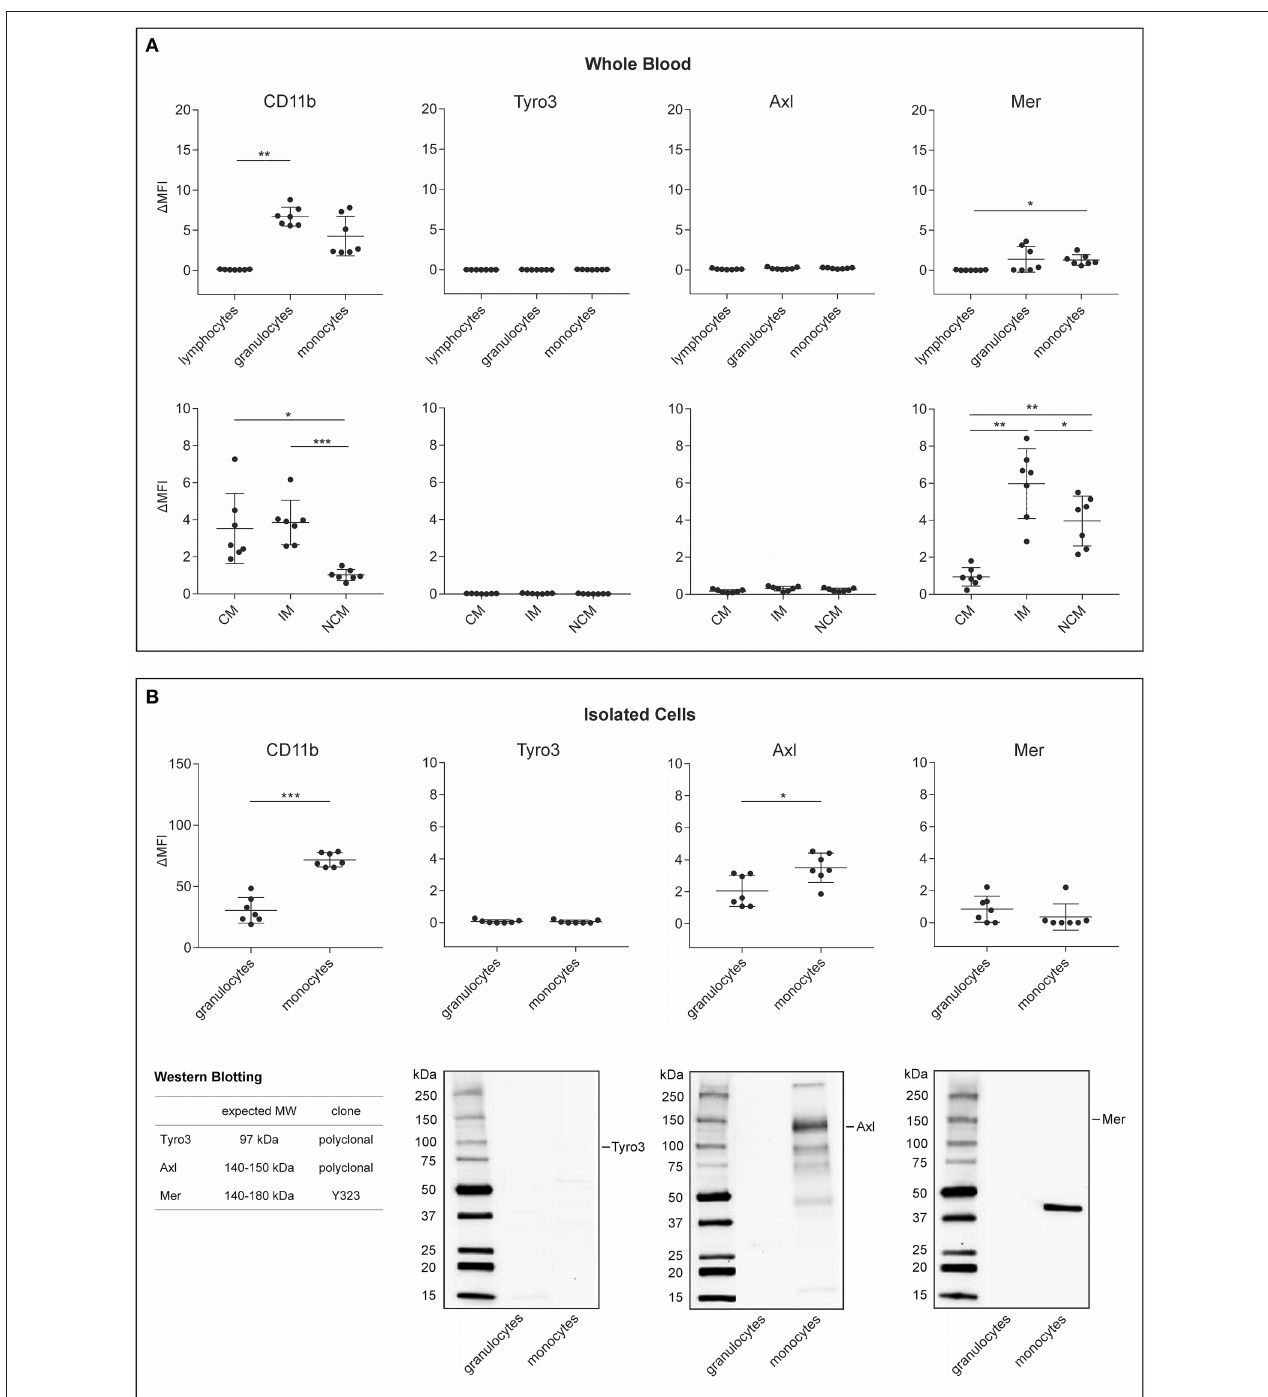
FIGURE 2 | Expression of CD11b and TAM receptors on leukocytes and monocyte subsets in human whole blood and on isolated immune cells. The surface expression of activated CD11b, Tyro3, Axl, and Mer was assessed directly in whole blood on (A) lymphocytes, granulocytes, and monocytes (upper panel) as well as on classical, intermediate, and non-classical monocytes (CM, IM, and NCM, lower panel) using flow cytometry ( n = 7). The flow cytometric characterization of monocyte subsets in whole blood and in isolated monocyte preparations is shown in Figure S2 . (B) Expression of activated CD11b and TAM receptors on isolated granulocytes and monocytes using flow cytometry ( n = 7). Data are given as mean ± standard deviation. * p < 0.05; ** p < 0.01; *** p < 0.001. TAM receptor expression on isolated granulocytes and monocytes using Western Blotting are shown in the lower panel. Ten microgram of protein were loaded per lane. The band detected for Mer does not correspond to full-length Mer, which has an expected molecular mass of 140–180 kDa, as indicated in the Figure. 1 MFI refers to the difference in mean fluorescence intensity between the fluorochrome-labeled specific antibodies and the corresponding isotype controls. MW, molecular mass.